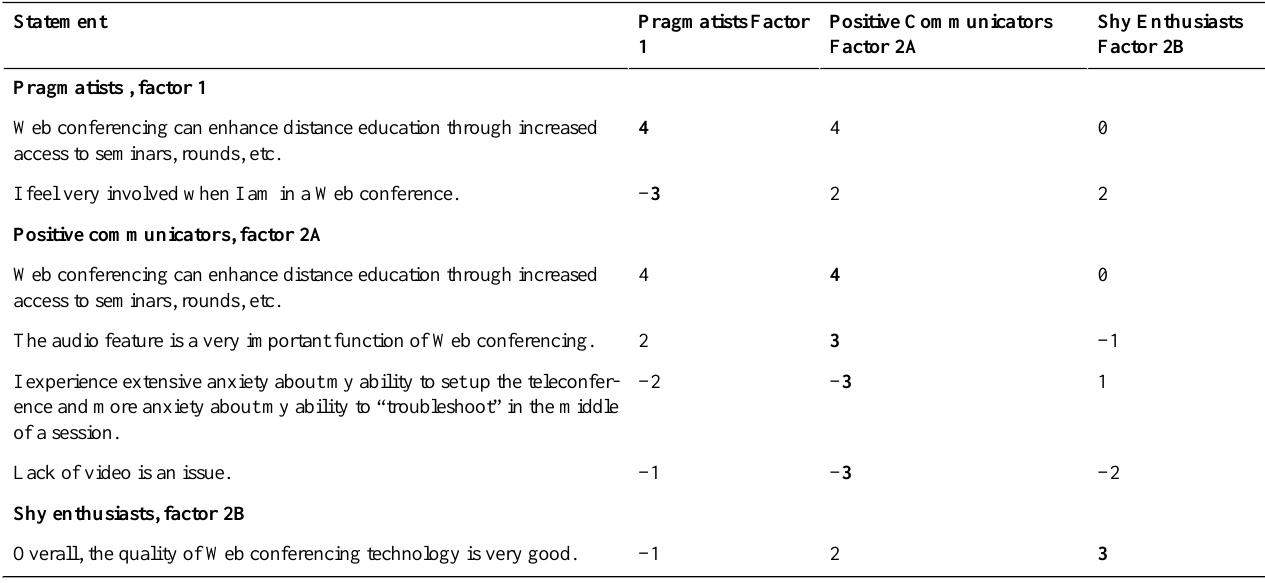
Pragmatists , factor